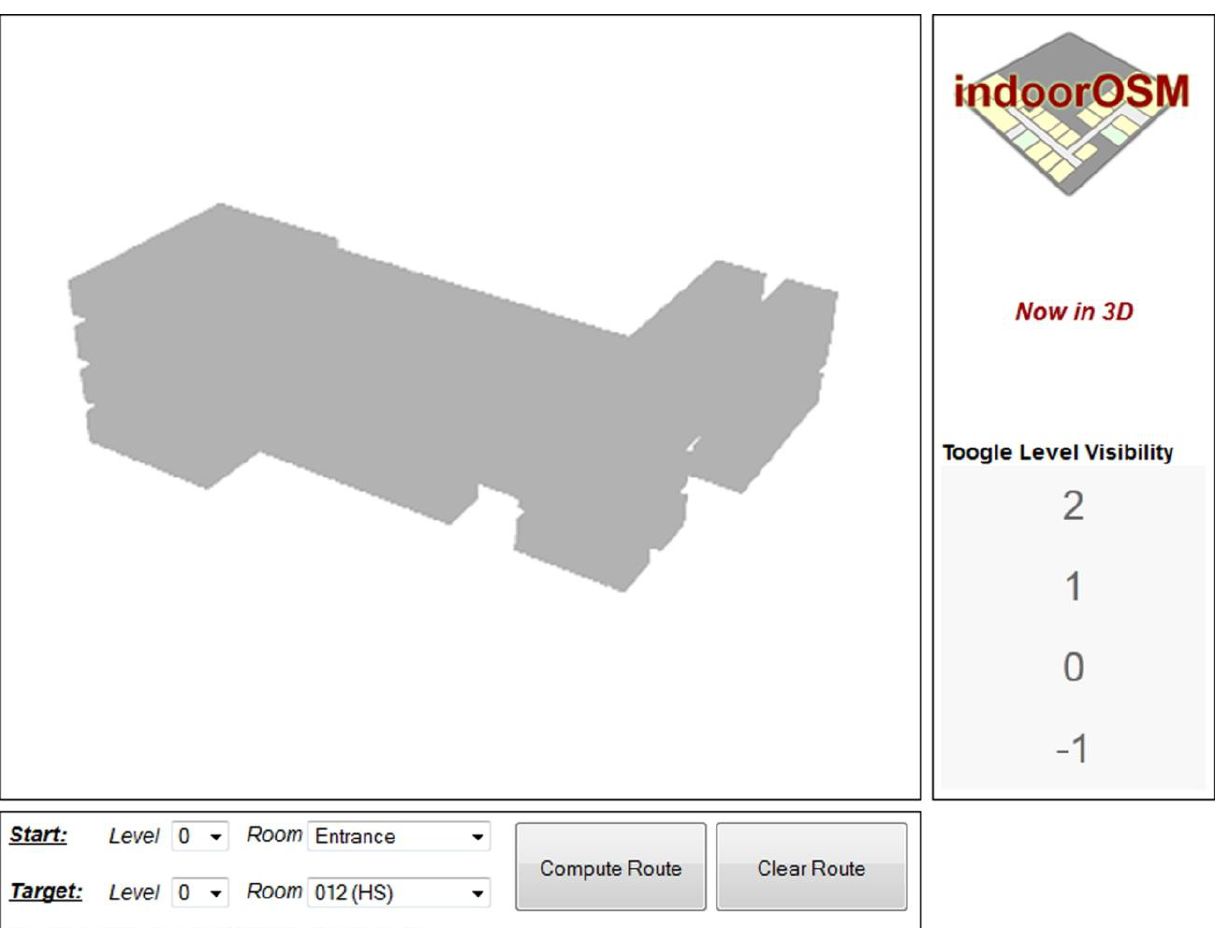
Figure 6. Indoor routing web application with XML3D scene